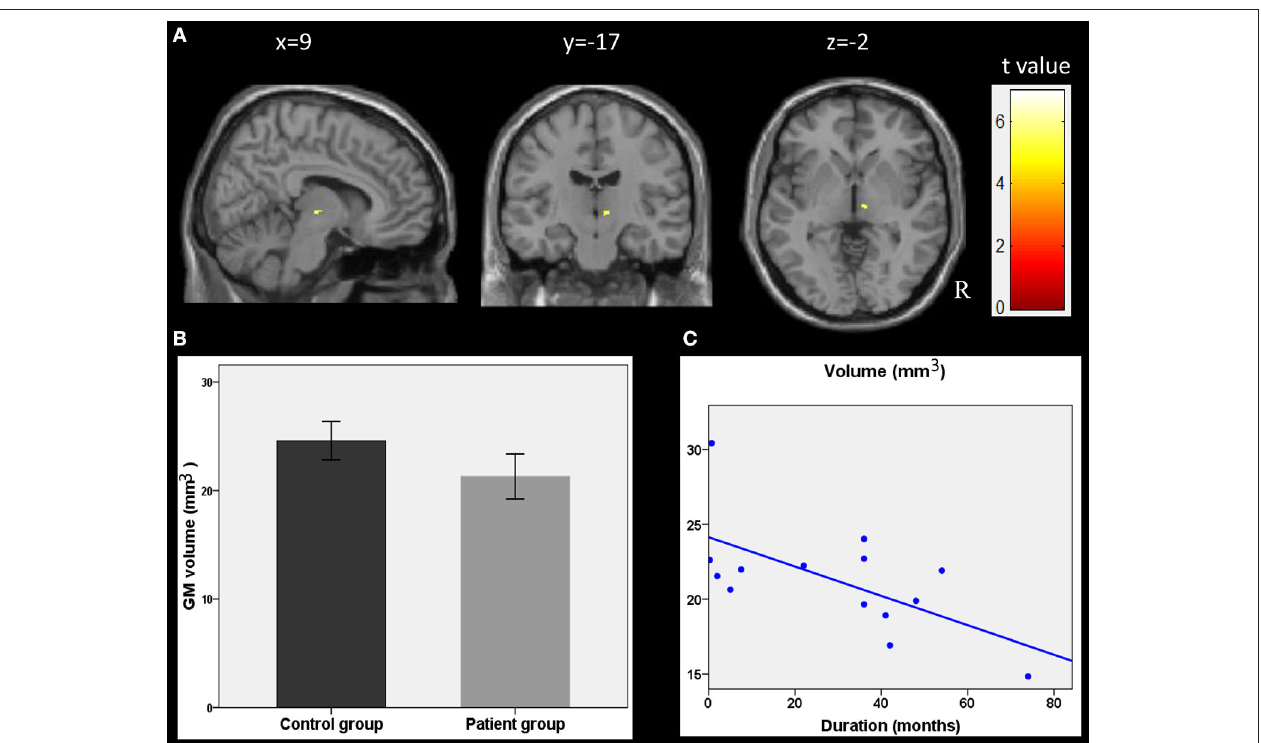
FIGURE 2 | Correlations between GM volumes and clinical characteristics. (A) Results of the correlation analysis between the epilepsy duration and GM volumes in children with epilepsy ( p < 0.001, uncorrected, cluster size > 15). (B) GM volumes in the cluster of right thalamus as showing in plane A. (C) the scatter plots between these cluster volumes and the epilepsy duration. The line was also drawn, which represent the direction of the association. R, right